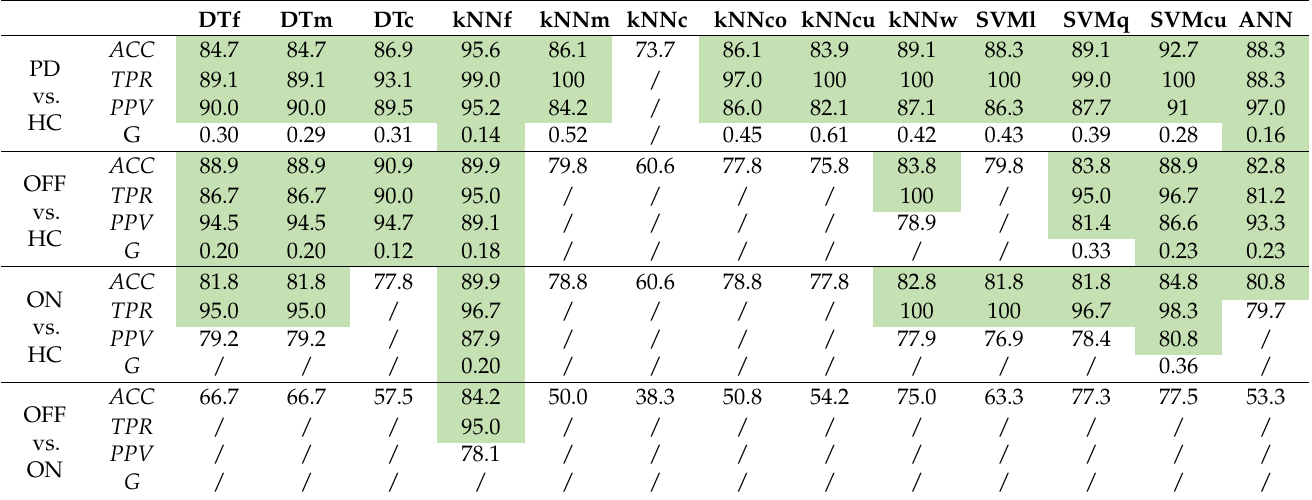
Table 3. Percentage values of each classifier for each criterion: accuracy ( ACC ), which represents the percentage of correct classification; recall ( TPR ), which represents the probability that an actual positive will test positive (positives are PD in PD vs. HC, OFF in OFF vs. HC and ON in ON vs. HC and OFF vs. ON); precision ( PPV ), which represents the percentage of true positive with respect to all positive; goodness index ( G ), which represents the Euclidean distance between the evaluated point in the ROC space and the point [0 1], representing the perfect classifier. Values exceeding the threshold and passing to the next selection are shown in green, those not exceeding the threshold are shown in white and values not passed are shown with